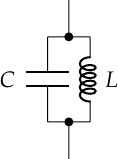
Figure 9. Parallel LC-type filter.